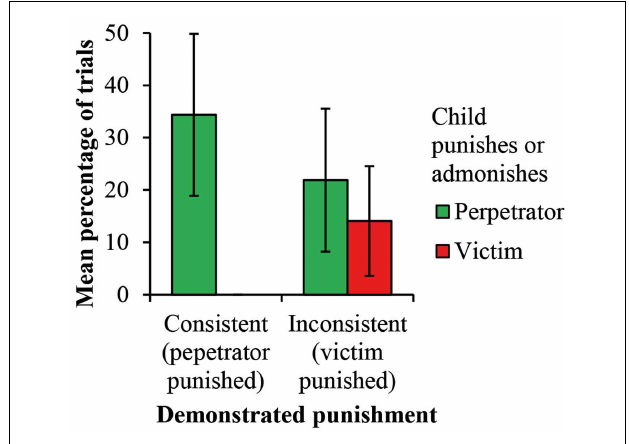
FIGURE 2 | Participants’ punishment and admonishment of the perpetrator and victim dolls following consistent and inconsistent punishment demonstrations. Error bars show 95% confidence intervals of the individual means.